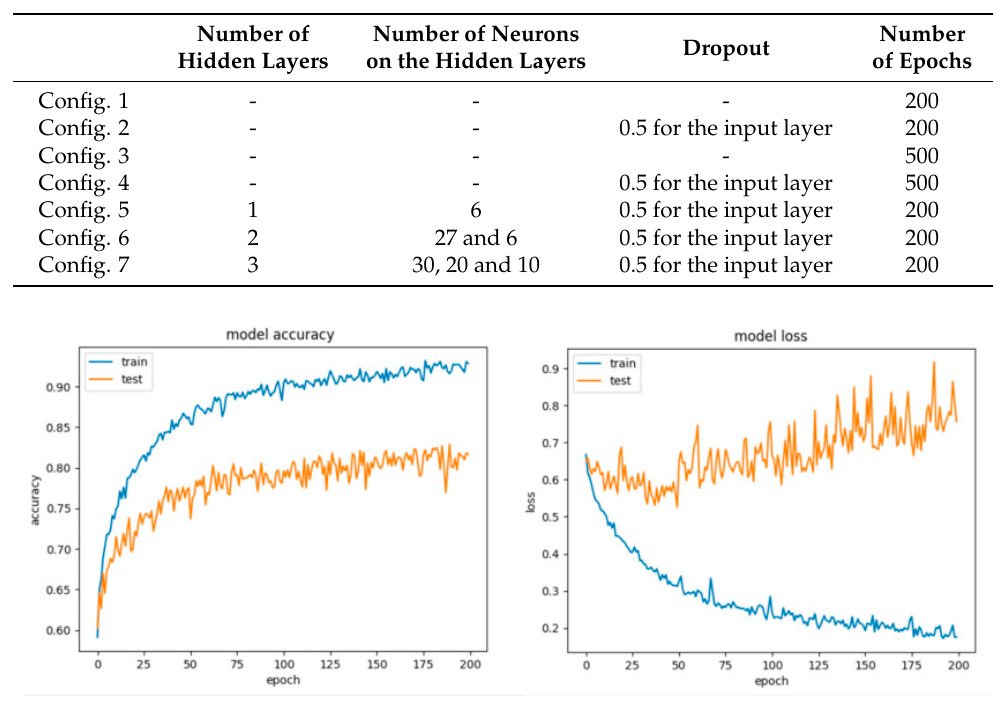
Table 13. Classification scores for Configurations 1–7, for the overlapping